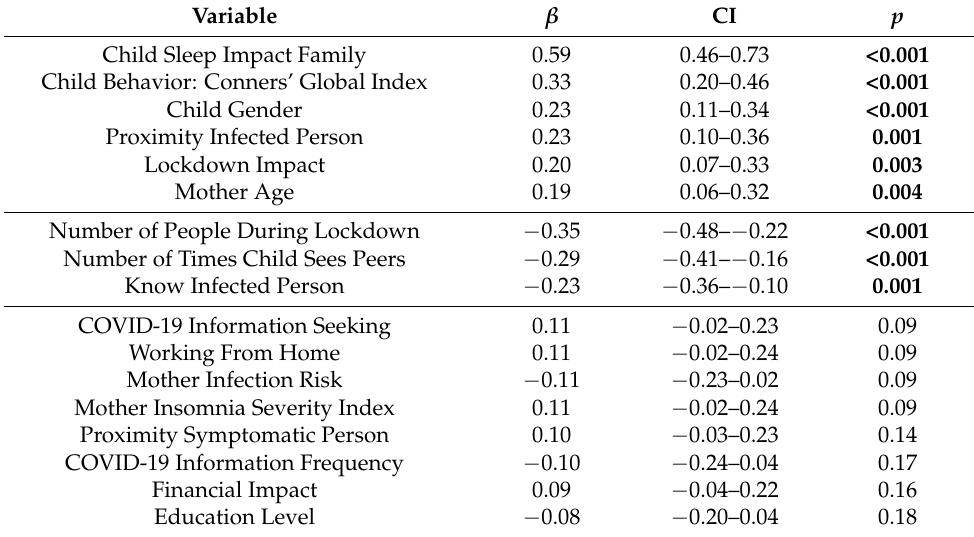
Table 1. Linear multiple regression results for the prediction of child insomnia (DIMS subscale of the SDSC, French sample).